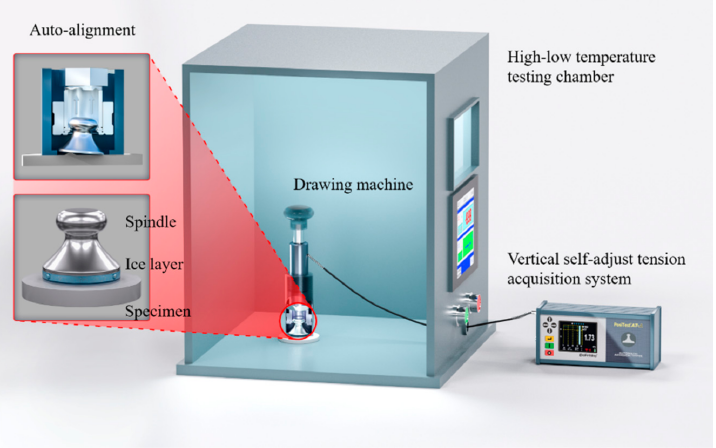
Figure 2. The schematic presentation of modified system for testing ice adhesion tension